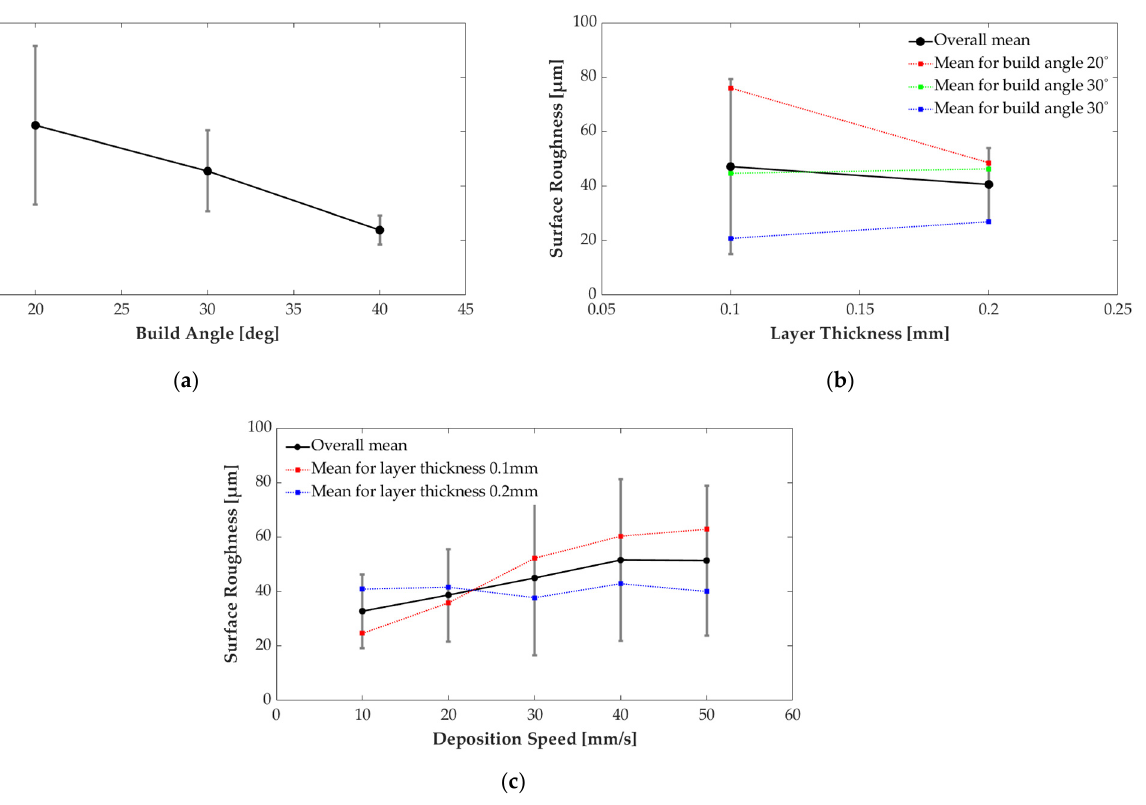
Figure 7. Effect of selected process parameters on surface roughness: ( a ) overhang angle; ( b ) Layer thickness; ( b ) Deposition speed.